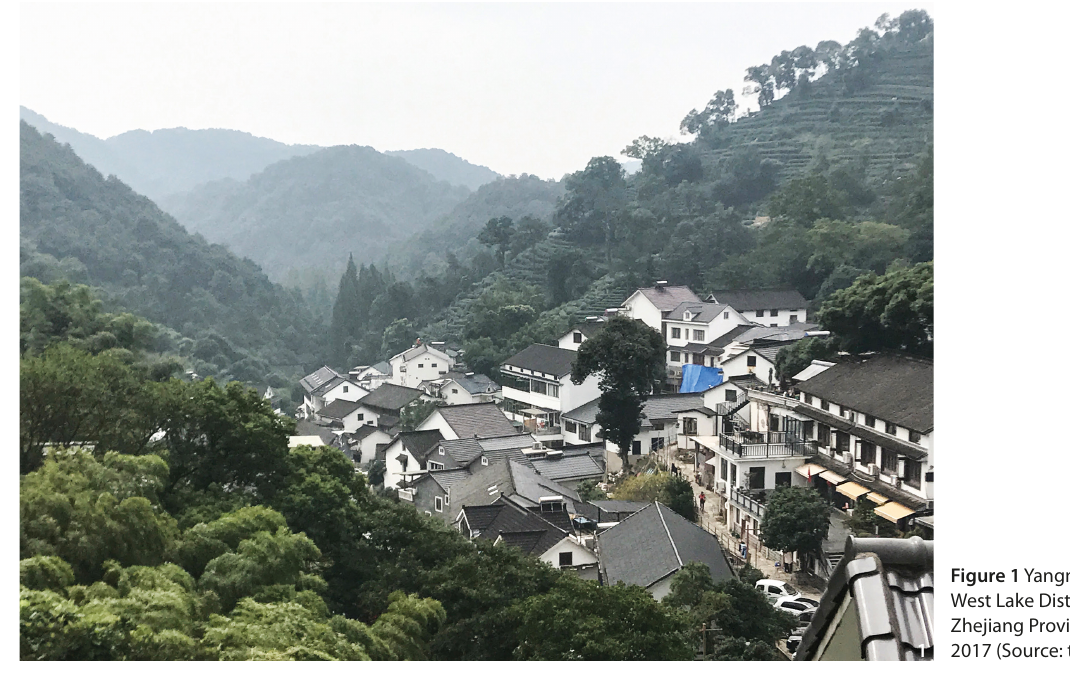
Figure 1 Yangmeiling village, West Lake District,